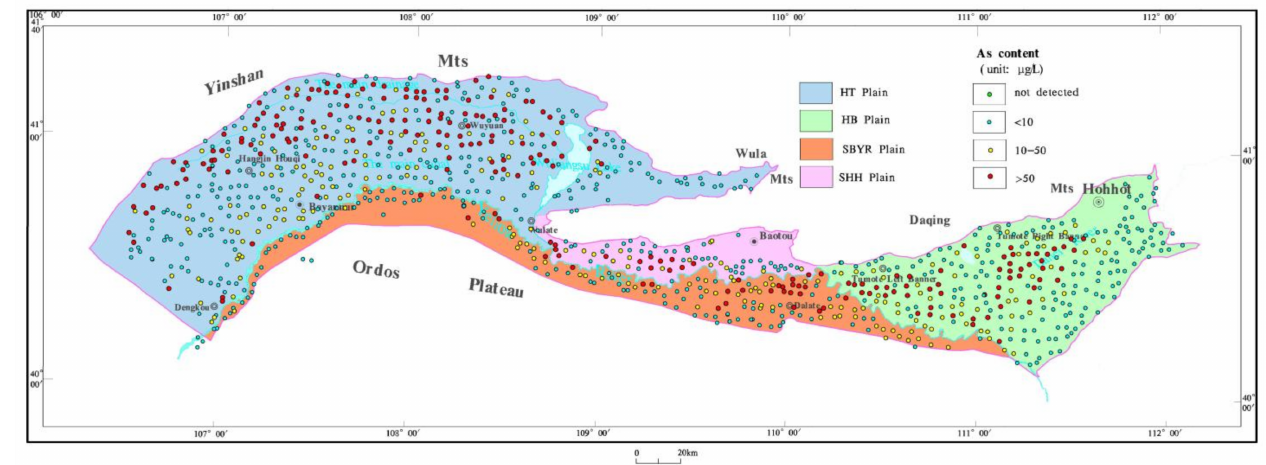
Figure 2. Arsenic content distribution of groundwater samples in the Hetao